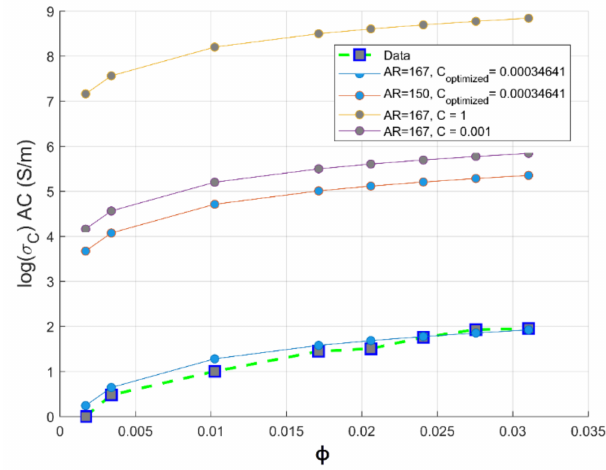
Figure 15. Experimental and theoretical electrical conductivity based on the modified Sohi